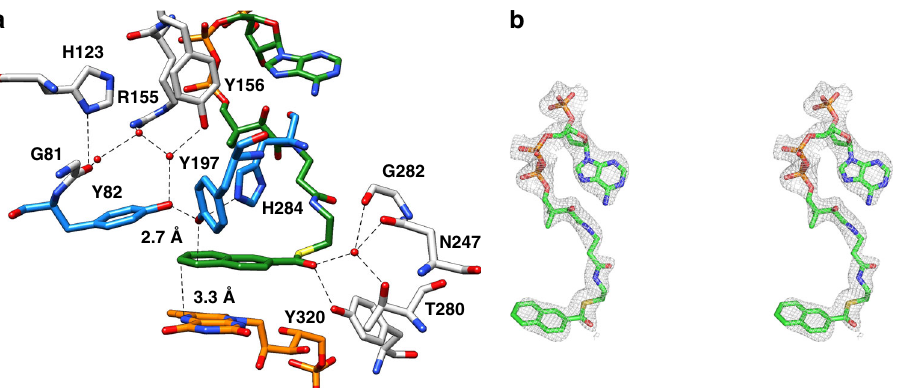
Fig. 5 Binding site of NCoA. a Active site geometry. The distances of hydride transfer from N5 of FMN (orange) and proton transfer from Y197 to the naphthoyl ring are indicated (carbons are shown in green). Y197 is hydrogen bonded with H284 and Y82 (all highlighted in blue), both contributing to an enhanced acidity; the proton network to the bulk solvent via bound water molecules involves Y156, R155, G81, and H123. A potential enolate intermediate at the thioester carbonyl during NCoA reduction is stabilized by Y320, G282, N247, and T280. b Stereo image of NCoA with the corresponding omit map (as gray meshes at a contour level of 0.5 σ ). NCoA is bound in an ‘ S ’ -like conformation. Although not completely occupied, all moieties of NCoA are also clearly visible in the 2 F o – F c electron density map at a contour level of 1